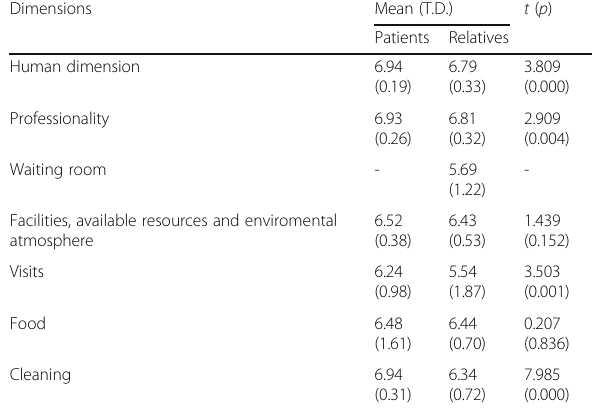
Table 1 (abstract 000864). Descriptive analysis of the factors of the ICU quality scale